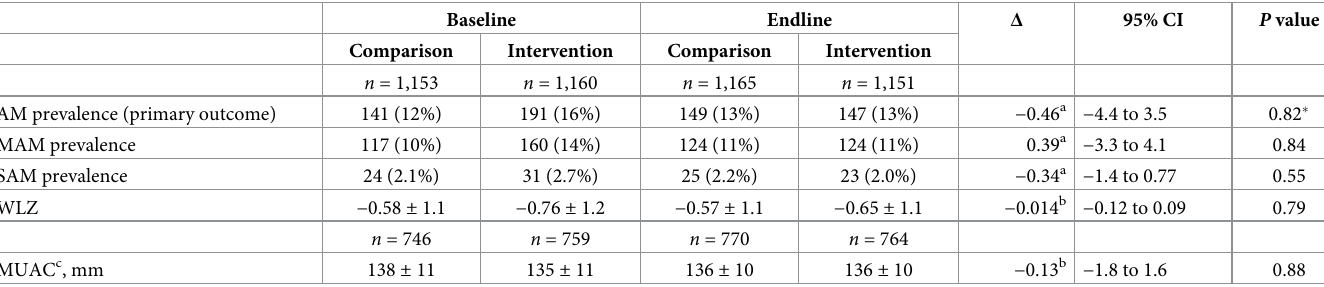
Table 5. Effect of the intervention on AM outcomes assessed by cross-sectional